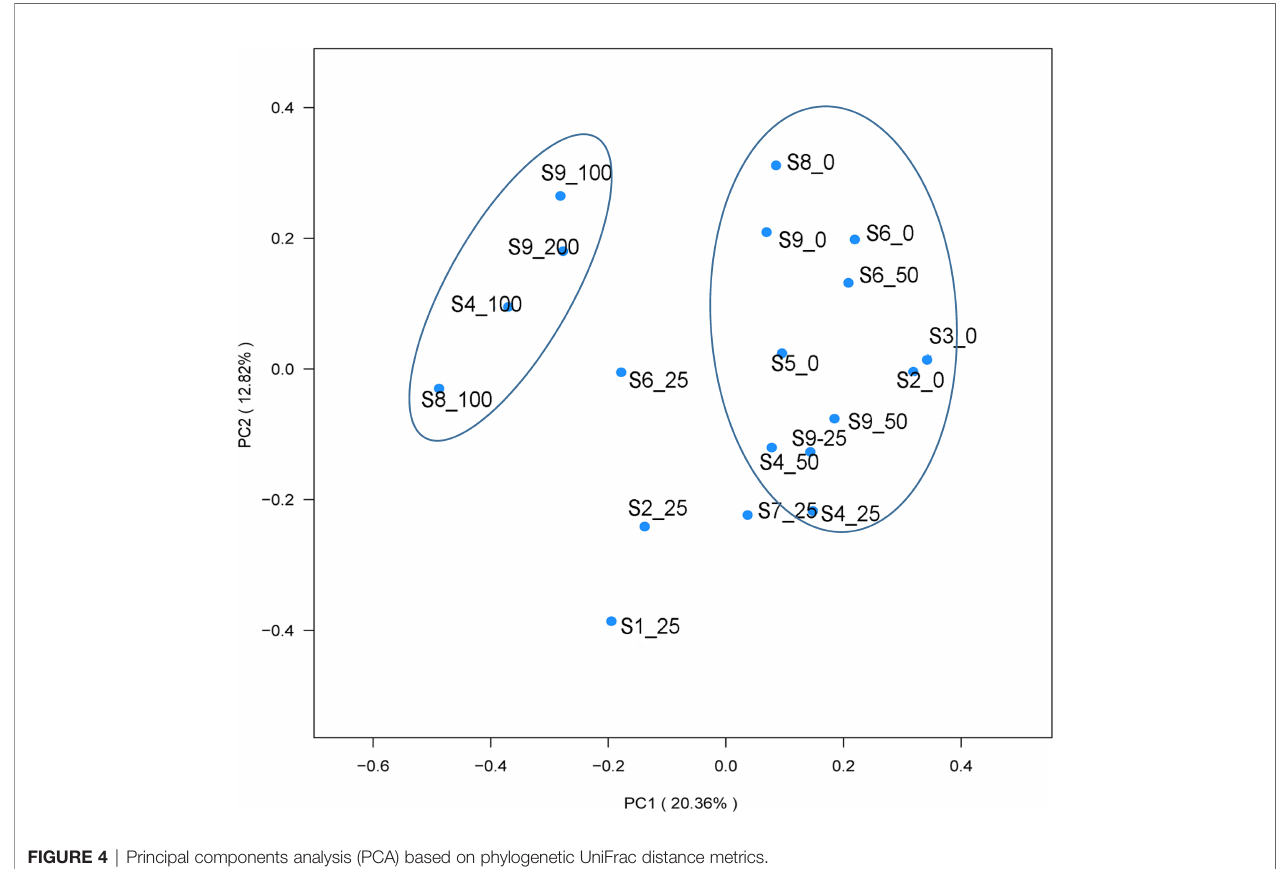
FIGURE 4 | Principal components analysis (PCA) based on phylogenetic UniFrac distance metrics.